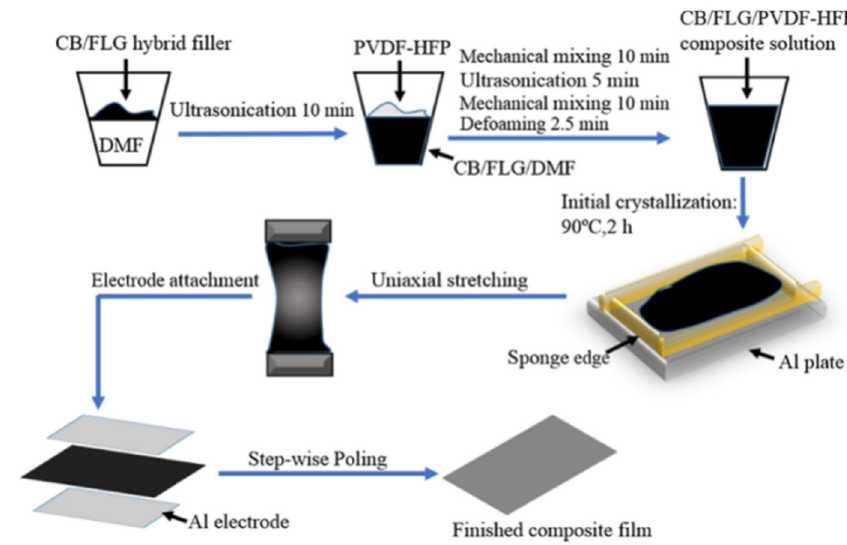
Figure 8: A typical solution - casting preparation process of PVDF - HFP fi lms [ 20 ]